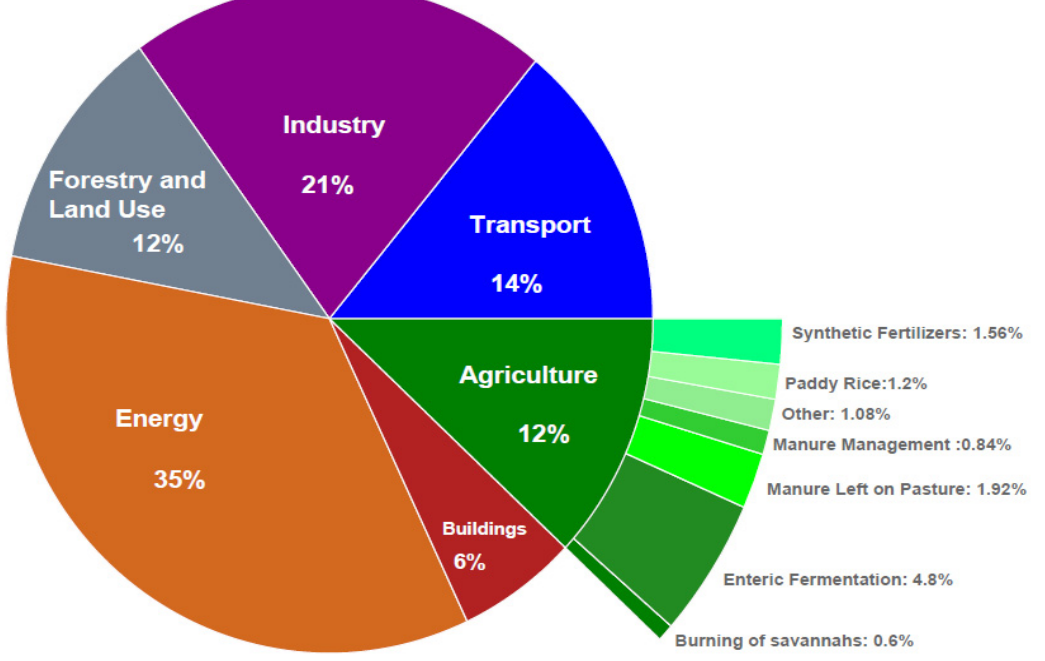
Figure 1. Contributing factors to greenhouse gas (GHG) emissions. Agriculture, forestry, and land use currently contribute approximately 24% of global GHG emissions; half of this is from agriculture, and the other half is from forestry and other forms of land use. The figure was created using data from the International Fund for Agricultural Development (IFAD) report [20].